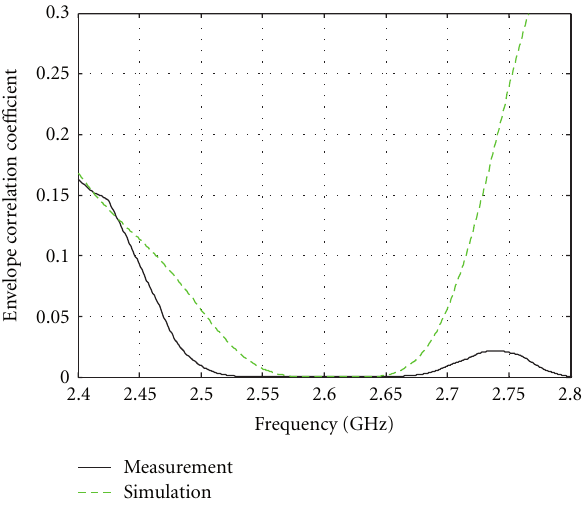
Figure 12: Envelope correlation coe ffi cient of the MIMO antenna system #2 (measurements versus